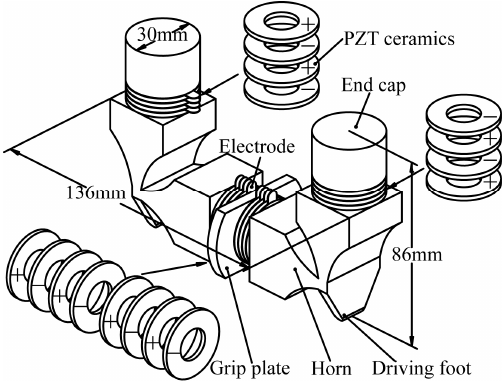
Figure 1. The three-dimensional structure of the modified piezoelectric ultrasonic motors (PUM).